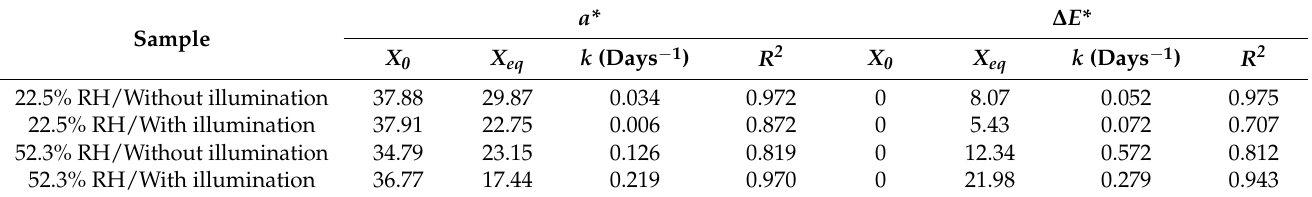
Table 1. Kinetic parameters for changes in a* and ∆ E* values during storage of the strawberry leather.